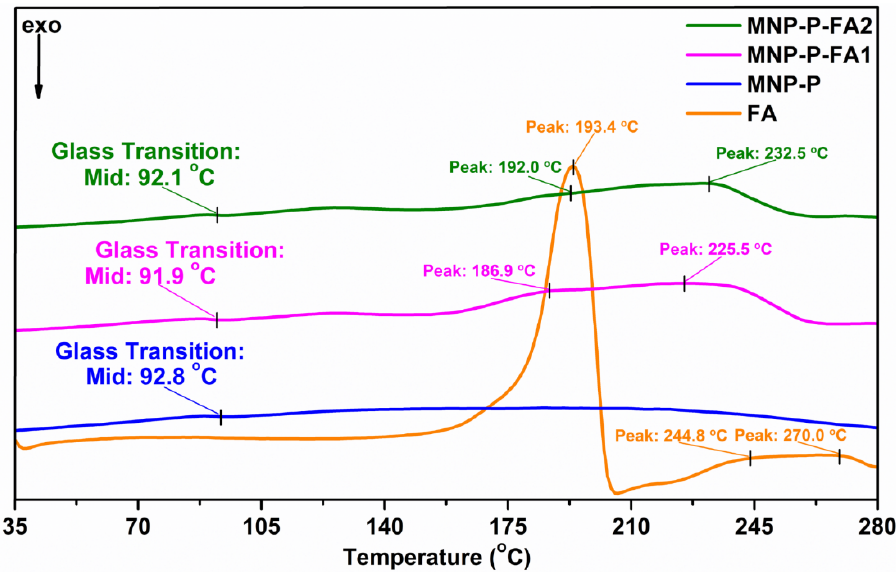
Figure 5. DSC curves of the studied samples: FA (orange), MNP-P (blue), MNP-P-FA1 (magenta), and MNP-P-FA2 (green). exo—exotherm.